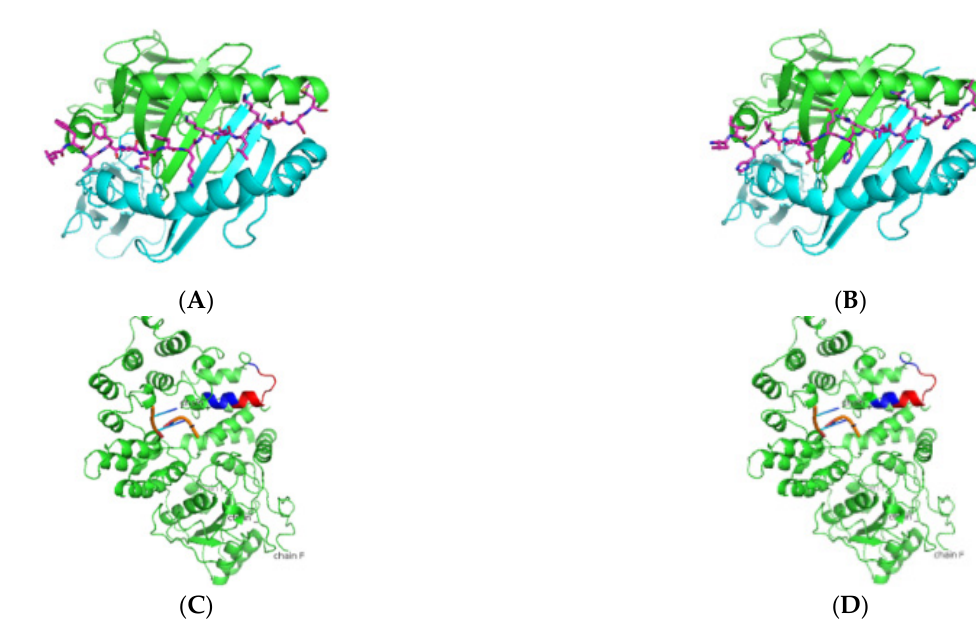
Figure 2. Predicted Ro60 peptide binders docked on HLA-DRB1*0103. ( A , B ) SMM-align predicted top two peptides FTFIQFKKDLKESMK and TFIQFKKDLKESMKC with IC50 values of 75 were docked onto the crystal structure of HLA-DRB1*0103 PDB structure 1A6A, and the most optimum predicted position of docking is indicated. Both predicted peptides have the same core sequence FKKDLKESM. ( C , D ) The highlighted region indicates the presence of the peptides in the three-dimensional structure of the Ro60 protein.